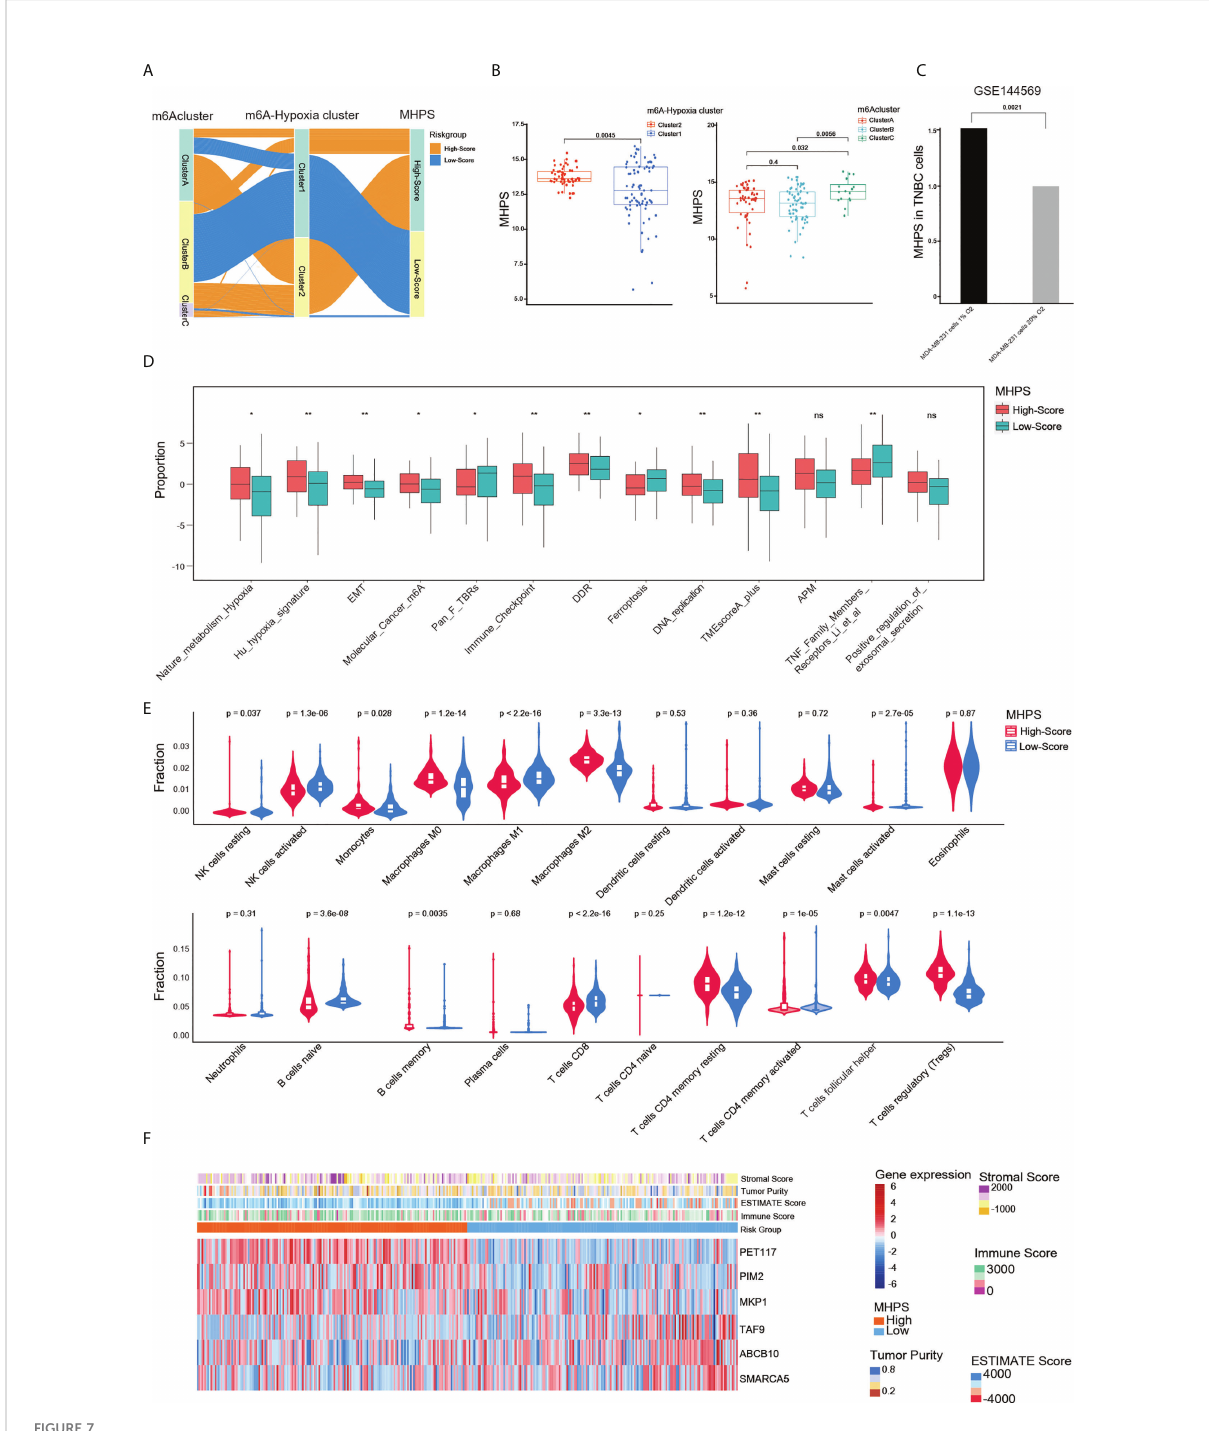
FIGURE 7 Evaluation of the clinical features of MHPS in TNBC. (A) Alluvial diagram of subgroup distributions in groups with different MHPS score, m6A clusters and m6A-hypoxia cluster. (B) Comparison of MHPS scores in 2 m6A-hypoxia and 3 m6A clusters. (C) Comparison of MHPS scores in MDA-MB-231 cell lines cultured under normoxia and hypoxia. (D) TME and hypoxia signatures score in high and low MHPS group. (E) Immune cell in fi ltration in high and low MHPS group. (F) Heatmap of hub gene expression pro fi le and immune score, ESTIMATE score, stromal score and tumor purity distribution in high and low MHPS group. (*P< 0.05 and **P< 0.01). ns, not signi fi